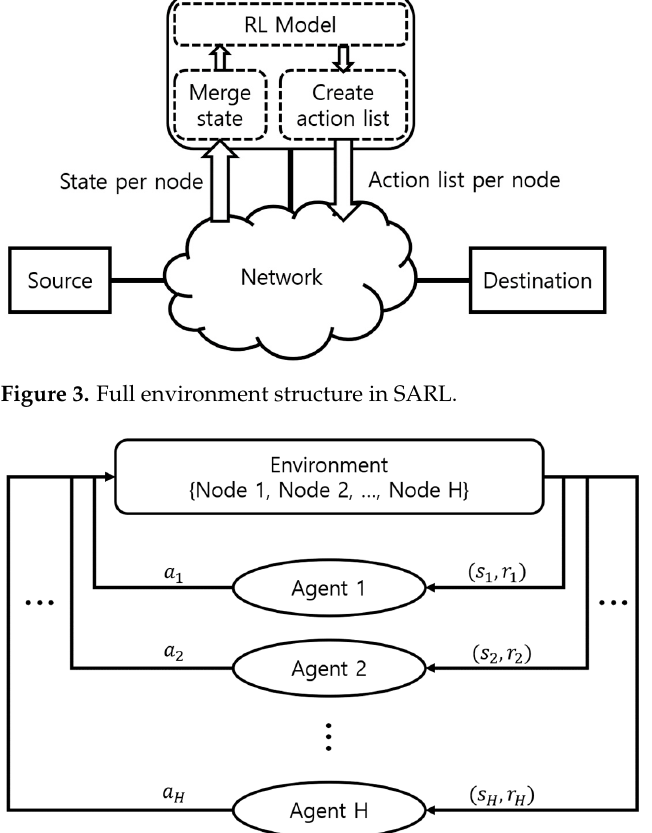
Figure 3. Full environment structure in SARL.